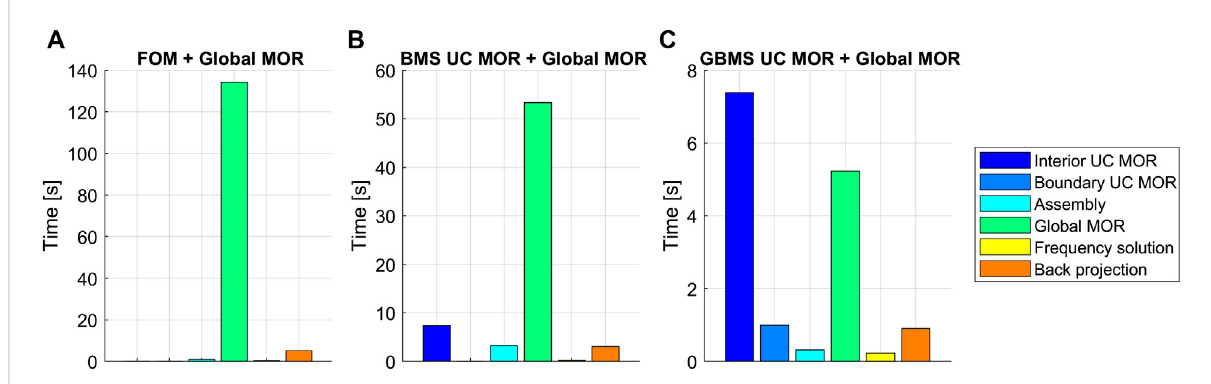
FIGURE 5 Overview ofthecomputationtimes fortheforcedvibration responsecalculationsoftheclamped fi niteLRM plateassembly of5× 5UCsfor the FOM (A) , BMS (B) and GBMS (C) based UC ROMs, all applying global MOR. The time ranges on the vertical axis differ per case for readability.